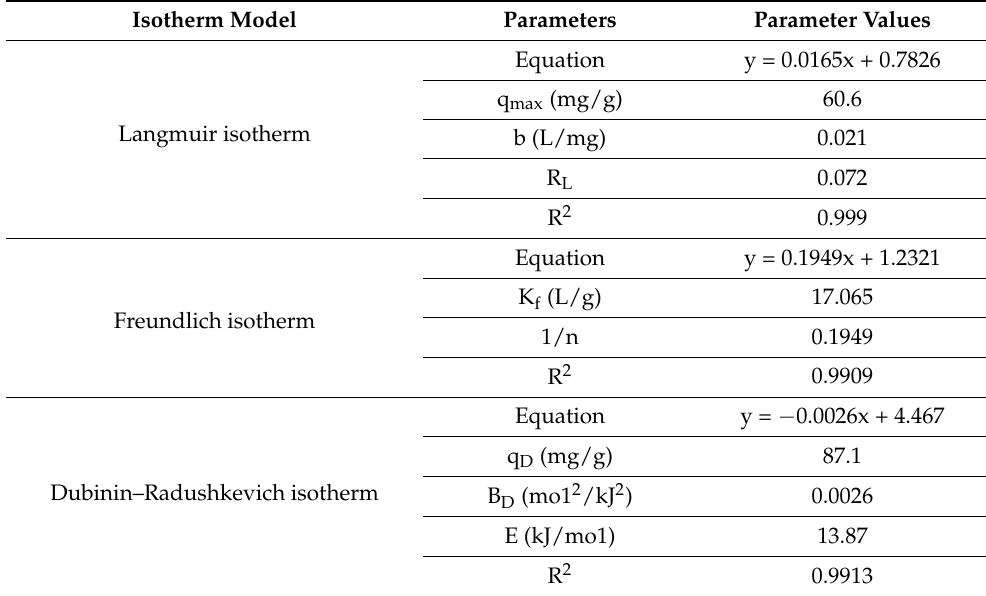
Table 3. Parameters of isotherms of different models for niobium sorption by Purolite A-100 anionite. Isotherm